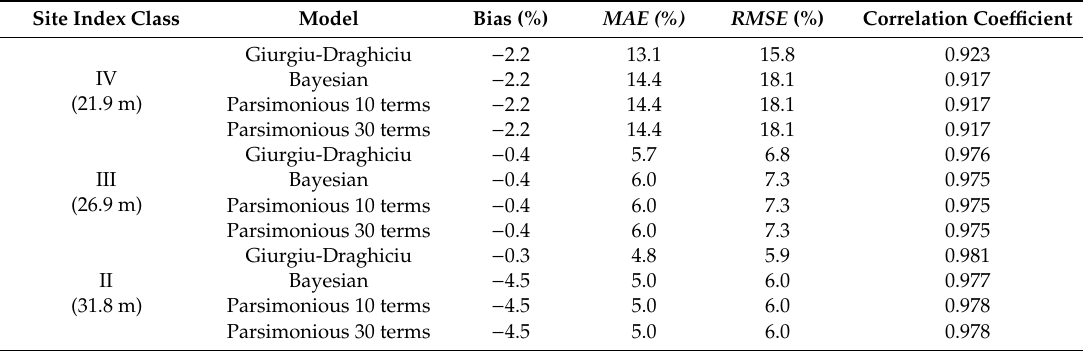
Table 2. Comparison of the site index models for the Norway spruce (index age 100